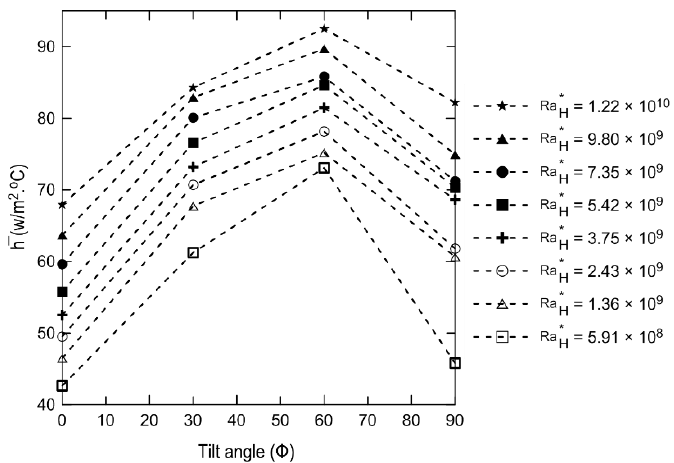
Figure 7. Heat transfer coefficient versus tilt angle for different Ra H∗ .